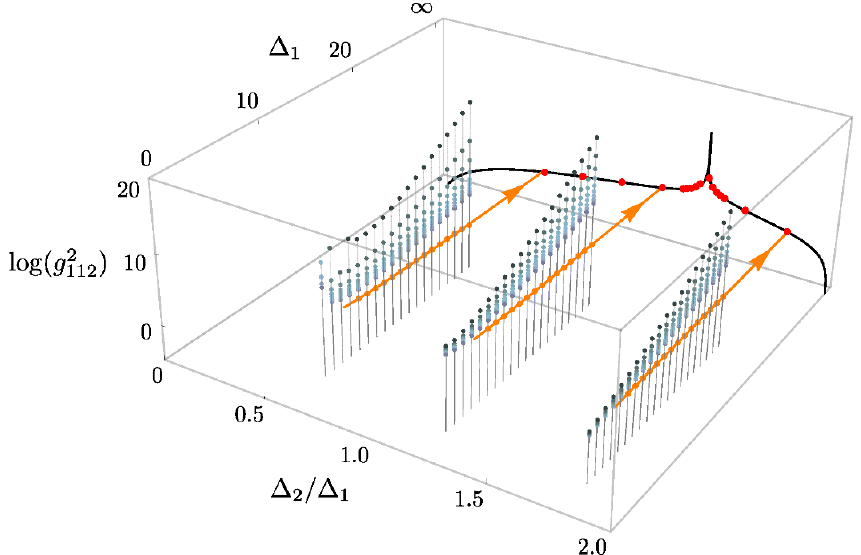
Figure 6 . Visualization of the double extrapolation procedure. Blue dots: some of our raw data points; each column of points corresponds to a series obtained with increasing N . Orange dots: extrapolation to N = 1 . Orange lines: (cid:12)ts and extrapolations to in(cid:12)nite (cid:1). Similar extrapolations from data not shown lead to the series of red dots at the back surface. These constitute our main result and are shown independently in (cid:12)gure 7. Black line: exact result from the S-matrix bootstrap [13] which tracks our numerical